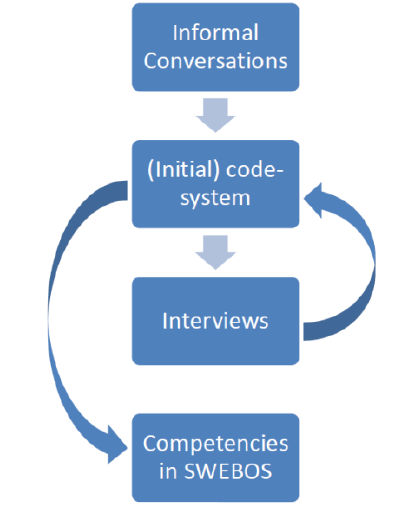
Figure 2. Research Process in Detail